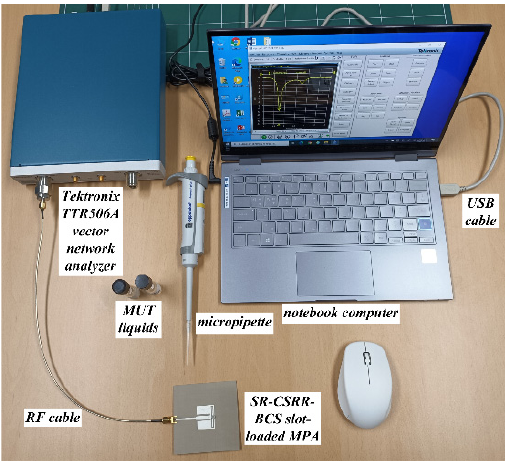
Figure 17. Measurement setup with a VNA and a notebook computer. For the RS-loaded MPA, the first resonant frequencies for air, ethanol, methanol, and water were 2.583 GHz, 2.509 GHz, 2.358 GHz, and 1.947 GHz, respectively. In contrast, the corresponding magnitudes of the input reflection coefficients at the first resonant frequencies were − 4.04 dB, − 11.05 dB, − 8.24 dB, and − 27.52 dB, respectively. The PRFS of the first resonant frequencies for ethanol, methanol, and water were 2.86%, 8.71%, and 24.61%, respectively.